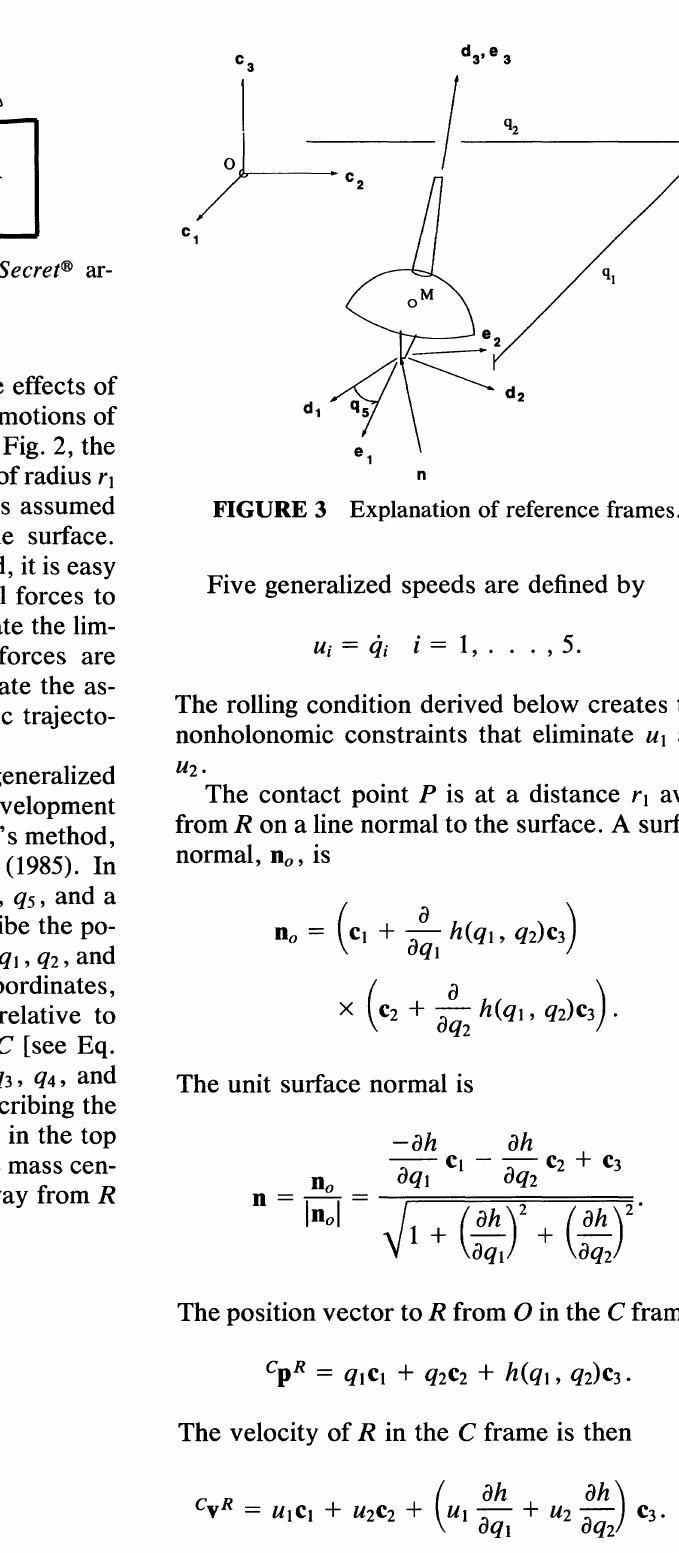
FIGURE 1 Cross section of the Top Secret® ar rangement.